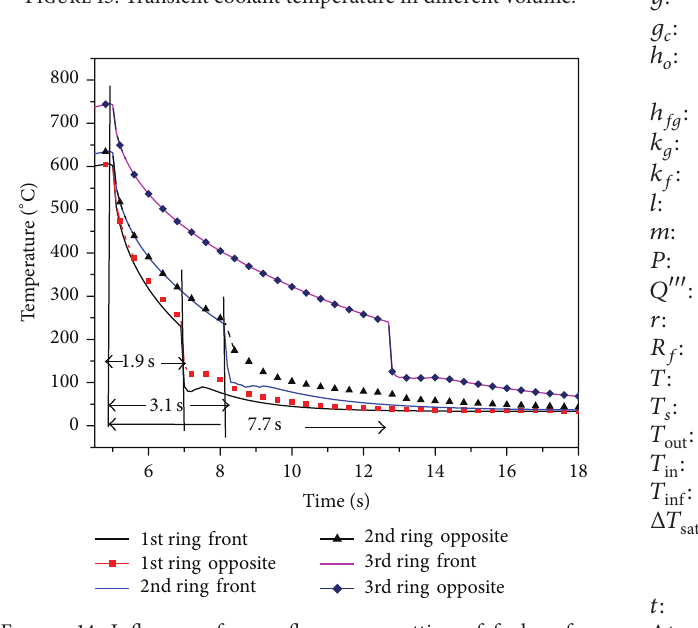
Figure 14: Influence of cross flow on rewetting of fuel surface temperature having radial